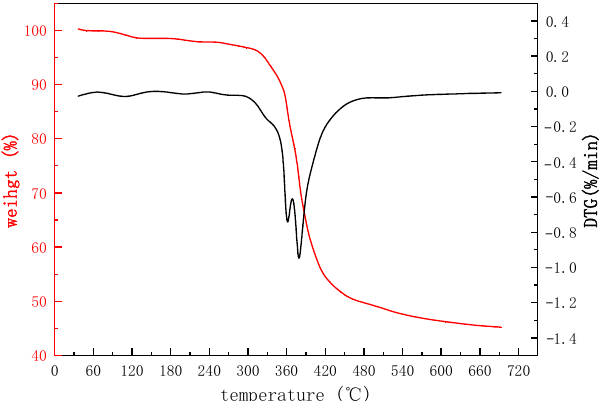
Figure 5. Thermogravimetric analysis results of PAASM-CaCO 3.